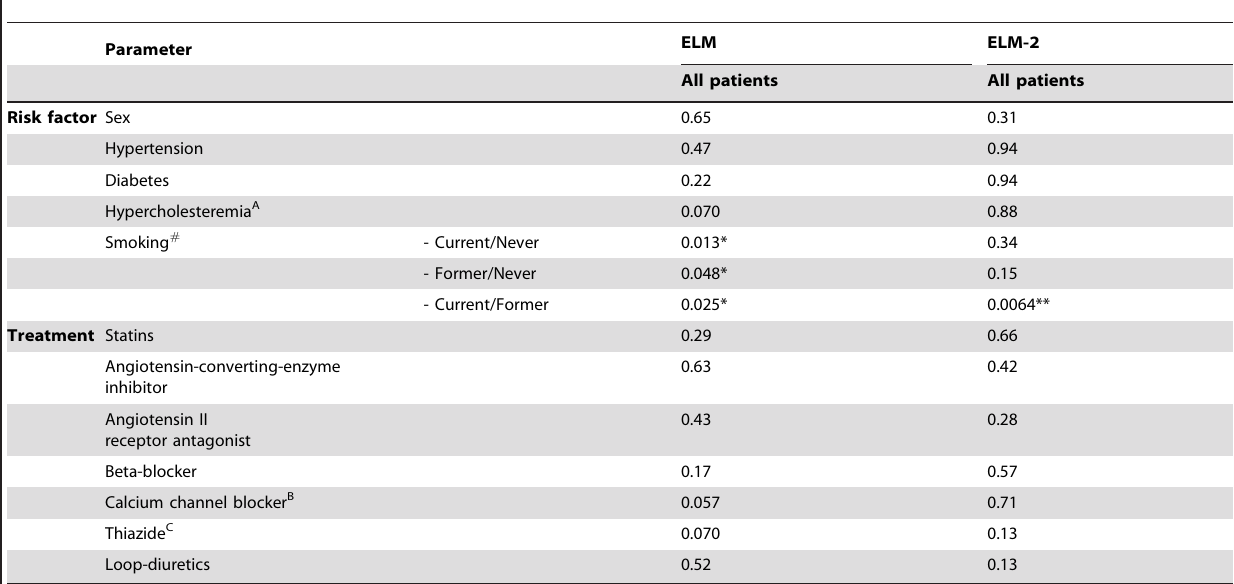
Table 3. Differences in elastin neoepitopes levels compared to patient parameters presented with p-values. n . 5.